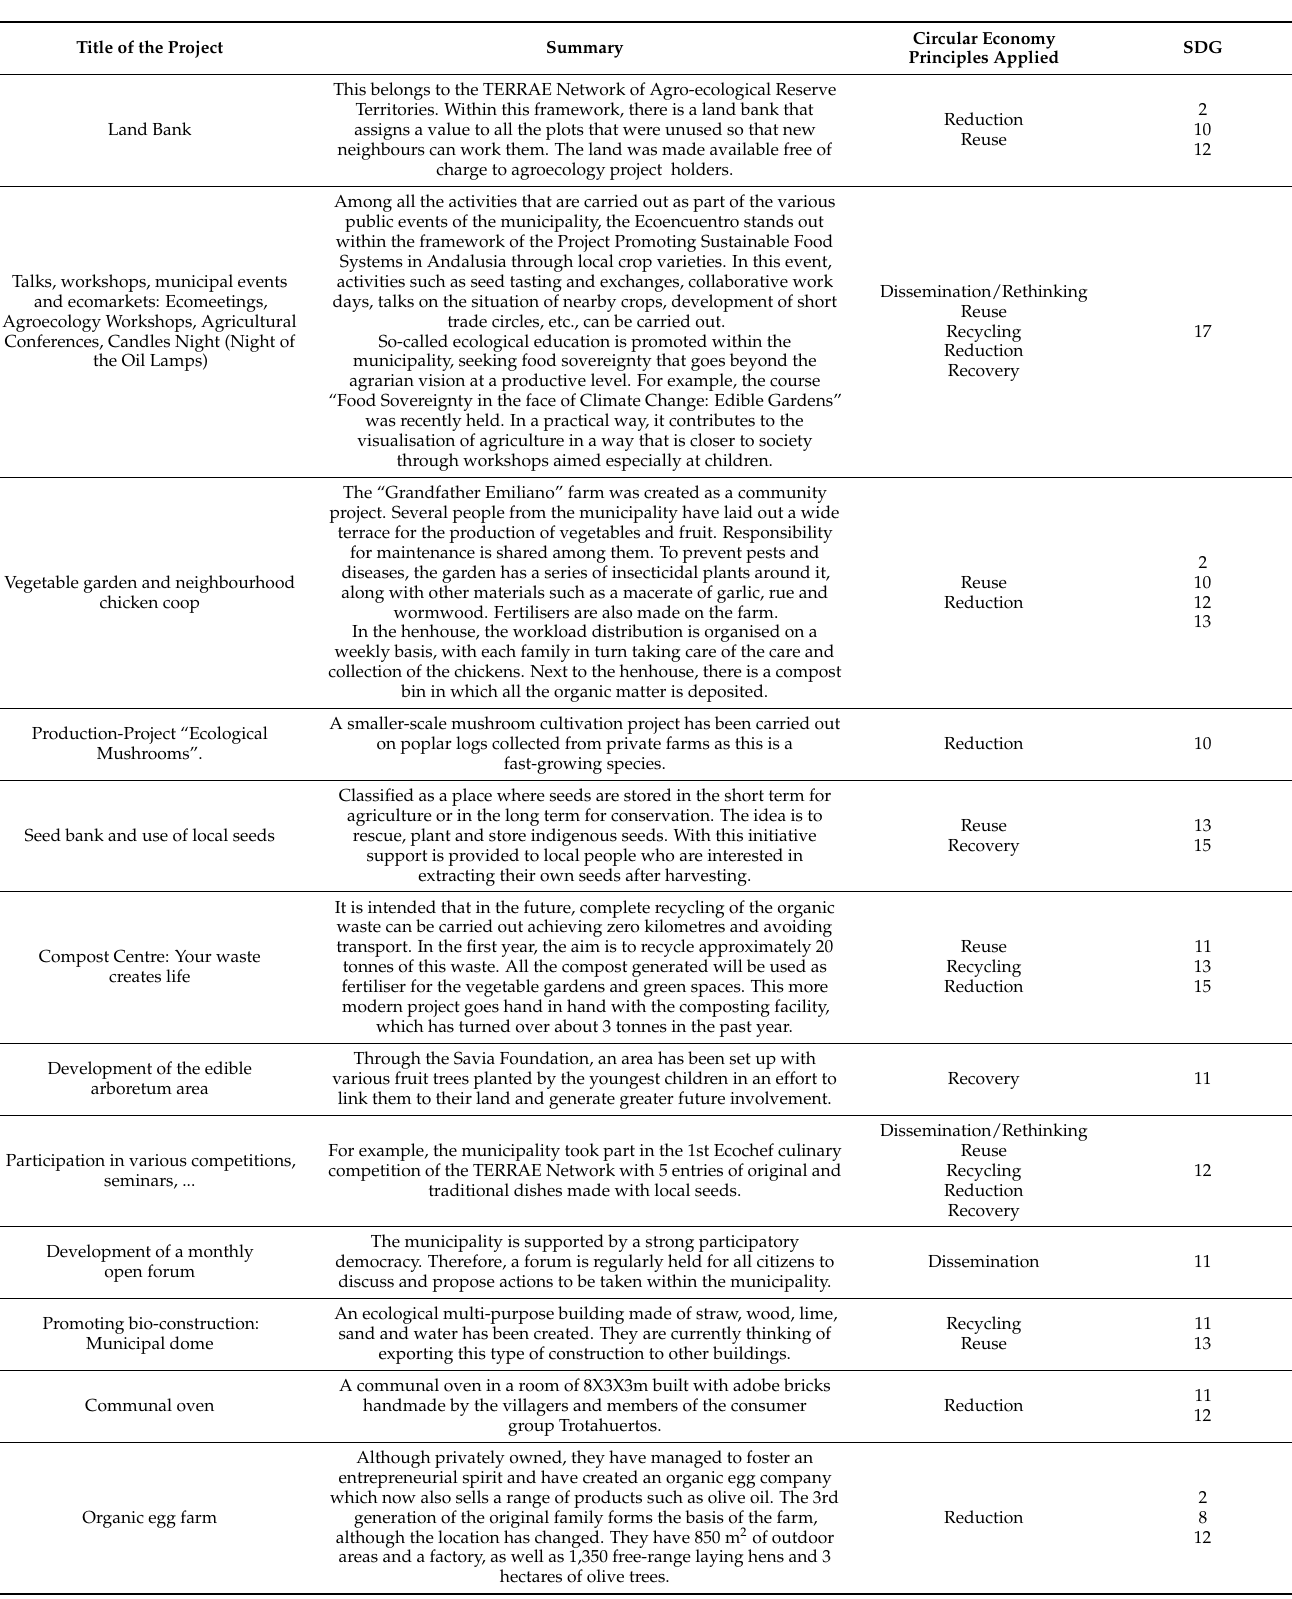
Table 3. Initiatives implemented prior to